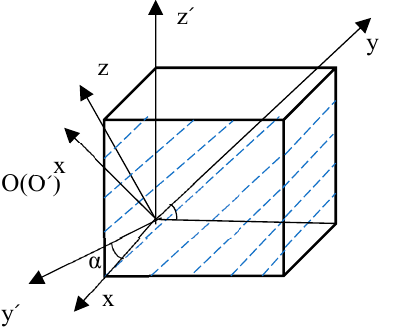
Figure 12 . Transversely isotropic constitutive model with isotropic plane inclines .